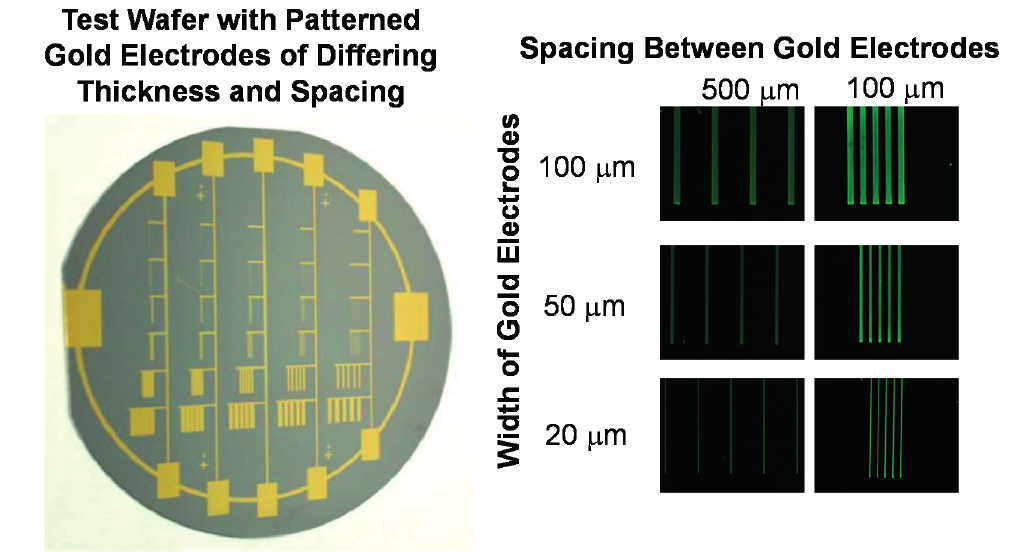
Figure 4. Spatial control of chitosan’s electrodeposition. Chitosan was deposited onto gold electrodes that had been patterned onto a silicon wafer. The test wafer was designed to have electrodes of varying width and spacing. After deposition, chitosan was fluorescently labeled to facilitate visualization. Reproduced with permission from [75], published by American Chemical Society,